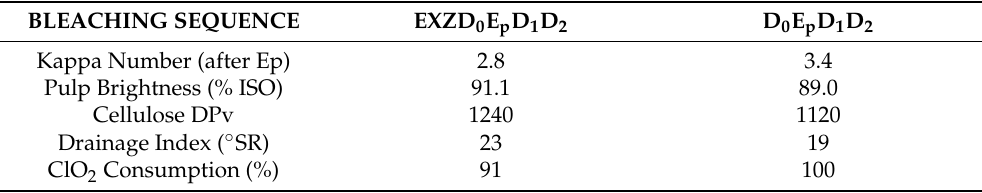
Table 1. Final properties of the O 2 -Delignified eucalyptus kraft pulp (after D 2 bleaching stage) for the enzymatic sequence (EXZD 0 EpD 1 D 2 ) using less 15% ClO 2 , and for the reference sequence (D 0 EpD 1 D 2 ) with ClO 2 reference loading.